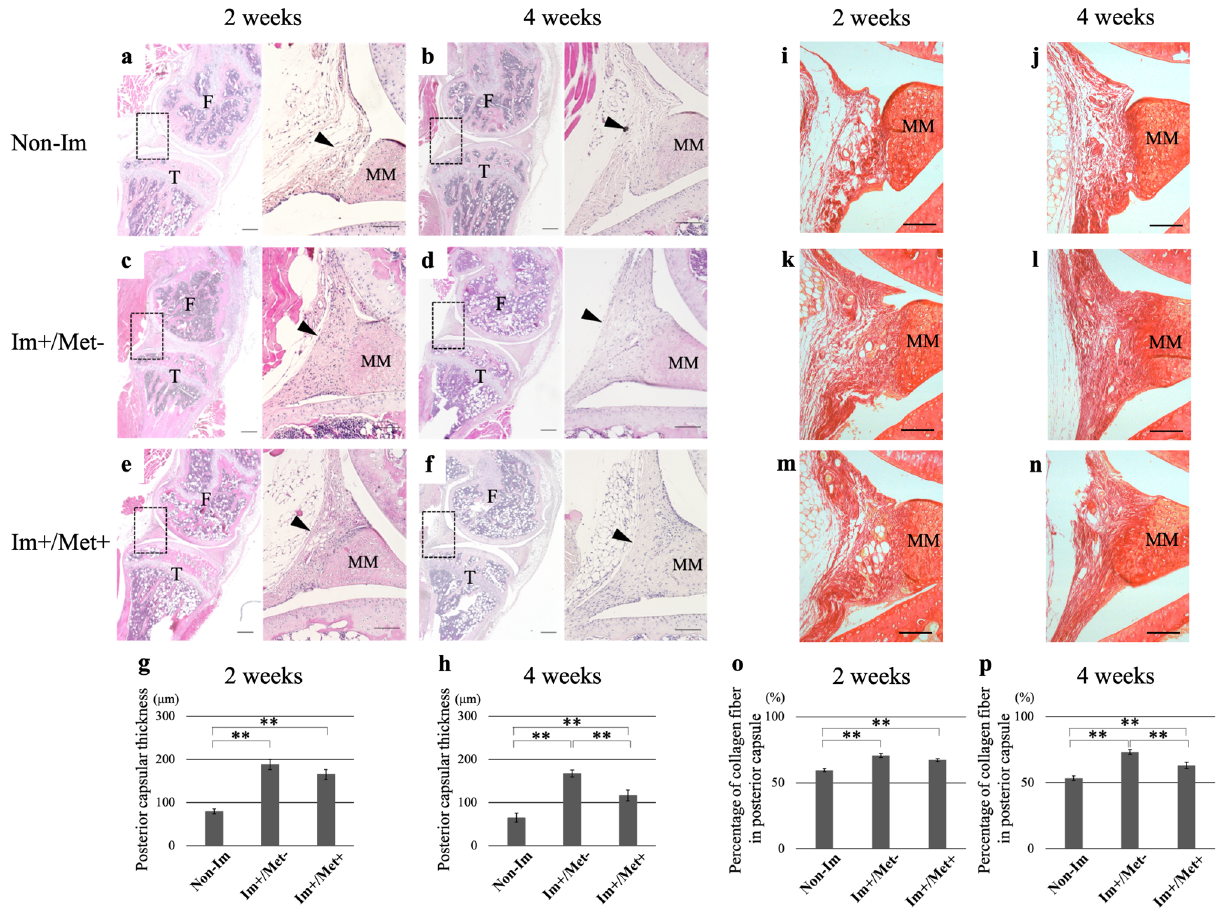
Figure 2. Histological analysis of the effect of metformin on joint capsular fibrosis. Hematoxylin and eosin-stained sections of the knee joints for each group at 2 and 4 weeks ( a – f ). The arrowhead indicates the posterior capsule. Each right-side image in ( a – f) shows the high magnification image of the dotted box of its corresponding left side image (Scale bar: 300 μm (right), 100 μm (left)). Posterior capsular thickness at ( g ) 2 weeks and ( h ) 4 weeks. Picrosirius red-stained sections of the posterior joint capsules for each group at 2 and 4 weeks ( i – n) (Scale bar: 100 μm). Percentage of collagen fiber in the posterior capsule at ( o ) 2 weeks and ( p ) 4 weeks measured as the ratios of the total areas stained red by picrosirius red staining to the areas of the posterior capsule. Data are expressed as the mean ± standard errors. **p < 0.01; n = 8. F femur, T tibia, MM medial meniscus, Non-Im mice with non-immobilized knees, Im+/Met− mice with immobilized knees but no metformin, Im+/Met+ mice with immobilized knees who were administered